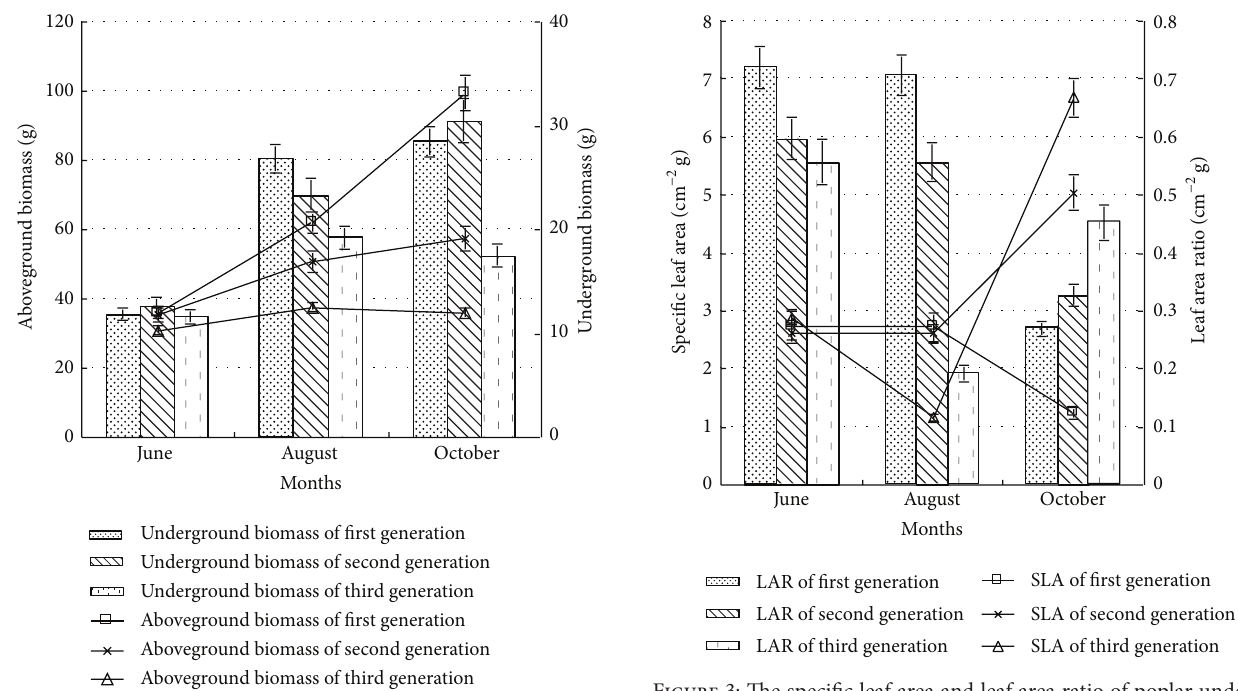
Figure 2: The aboveground and underground biomass of poplar under different continuous croppings.